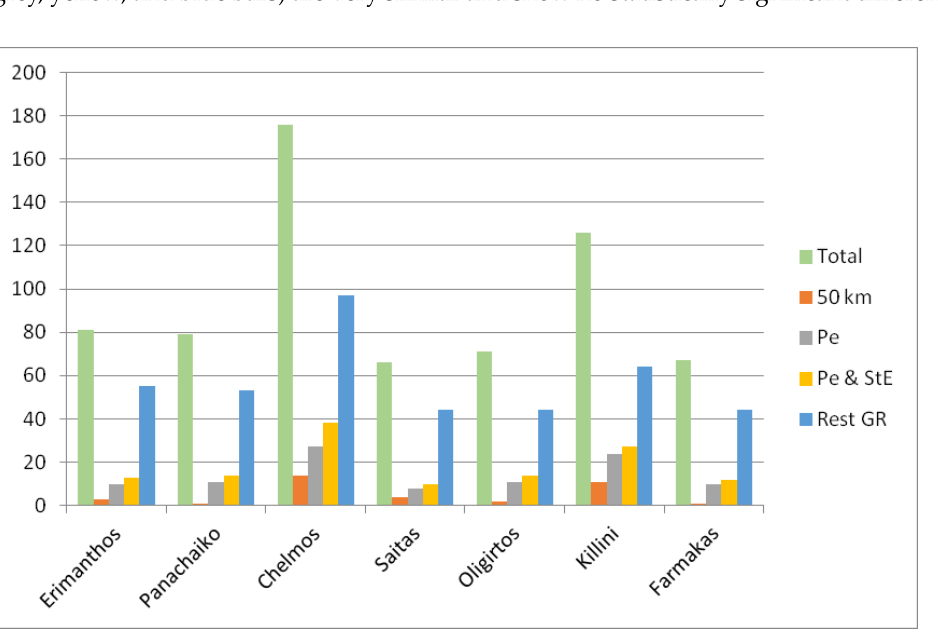
Figure 5. Number of Greek endemic taxa (Total), narrow endemics (50 km), Peloponnisos endemics (Pe), Peloponnisos and Sterea Ellas endemics (Pe and StE), and endemics with a wider distribution in Greece (Rest GR) recorded so far on Mts. Erimanthos, Panachaiko, Chelmos, Saitas, Oligirtos, Killini, and Farmakas. (Kruskal – Wallis one-way ANOVA: H = 5.577, df = 6, p = 0.472).